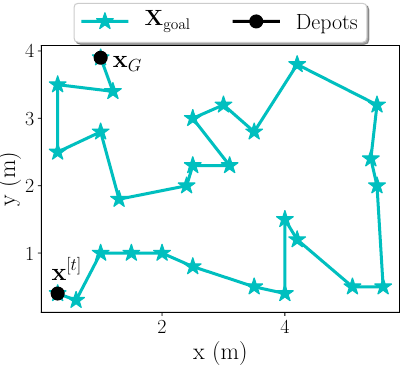
Figure 4. One-robot solving a multi-depot “vanilla” VRP: x [ t ] —current location; x G —goal location. Goals ( X goal ) are represented with blue asterisks and depots with black